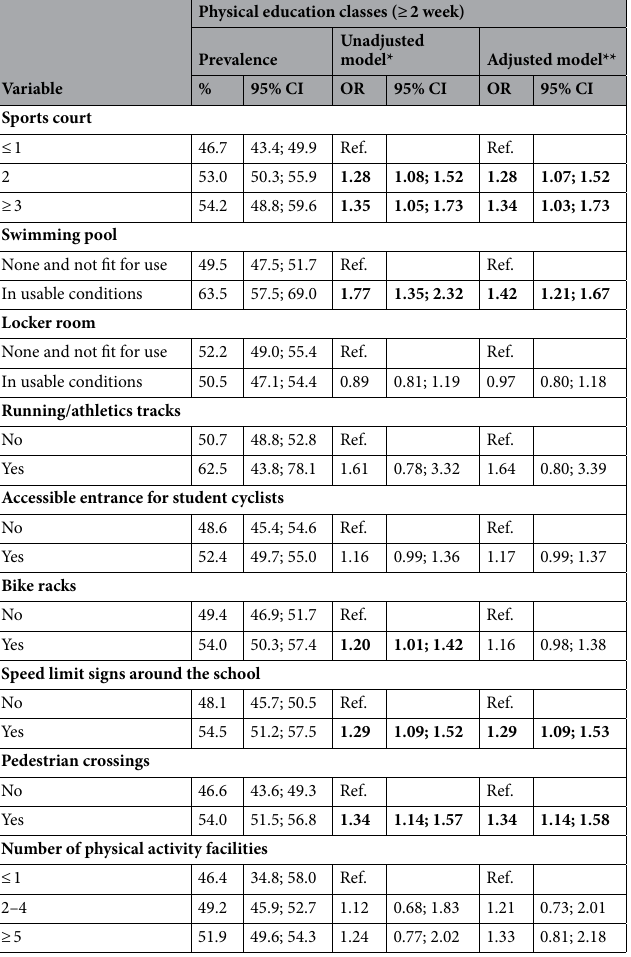
Table 4. Association between school characteristics and participation in physical education classes in adolescents. Values in bold indicate significant associations; 95% CI 95% confidence intervals, OR odds ratio. *Number of adolescents enrolled in the school as first level and type of school as second level. **Number of adolescents enrolled in the school as first level, type of school as second level, adjusted by sex, age (years), skin color/ethnicity, and mother’s employment